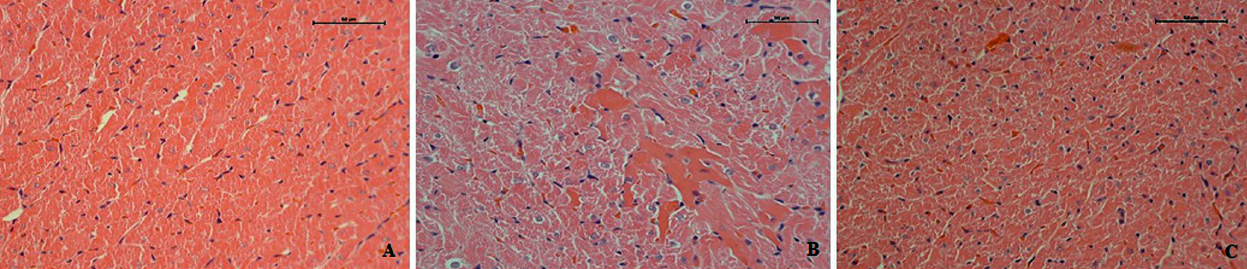
Fig. 4 - Photomicrographs of heart tissue stained with HE of animals subjected to hemorrhagic shock and fluid resuscitation with Ringer’s lactate (RL Group, photomicrograph B) or Ringer Lactate associated with N-acetylcysteine (RLNAC Group, photomicrography C), compared to a control group (Group GC, A photomicrograph). It is observed in A, normal myocardium; B, myocardial damage by the presence of cardiomyocyte hipereosinophilic (more intense pink); C, myocardial preserved.